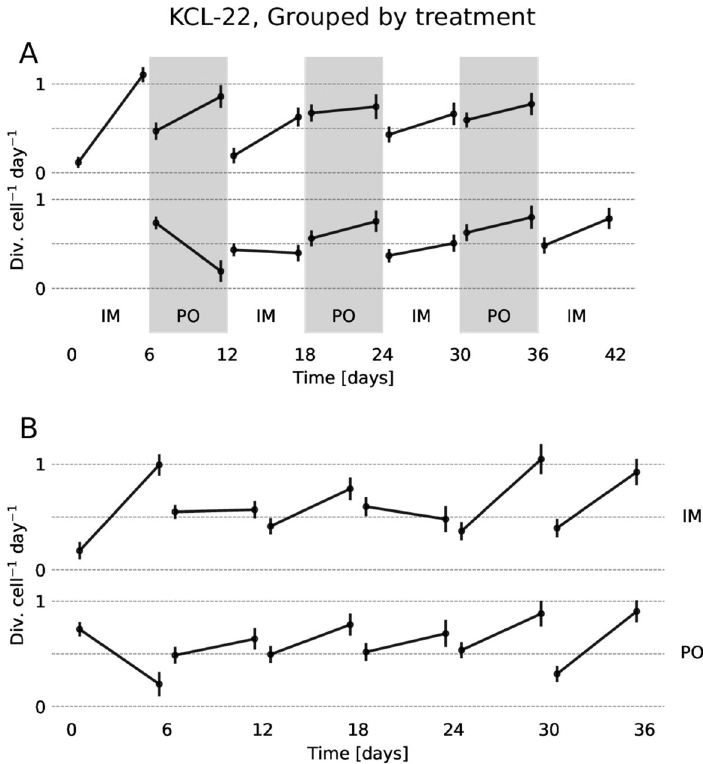
Figure 3. The inferred growth rate over time for KCL-22 cells. The error–bars show the standard deviation, and are inflated somewhat by a degree of multicolinearity between the initial and final growth rates. ( A ) The growth rate over time in cells exposed to drug rotations, aligned in time by the drug exposure. ( B ) The growth rate in cells exposed to monodrug therapy (washed every six days but not subject to drug rotation).